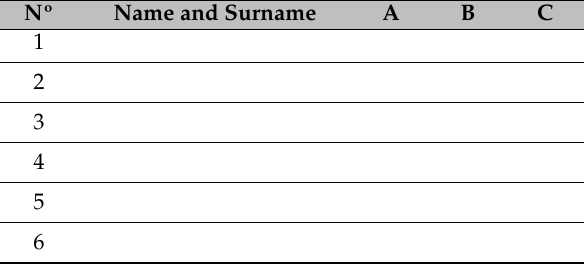
Table A2. Description of the instrument to evaluate socio-centric networks in classroom